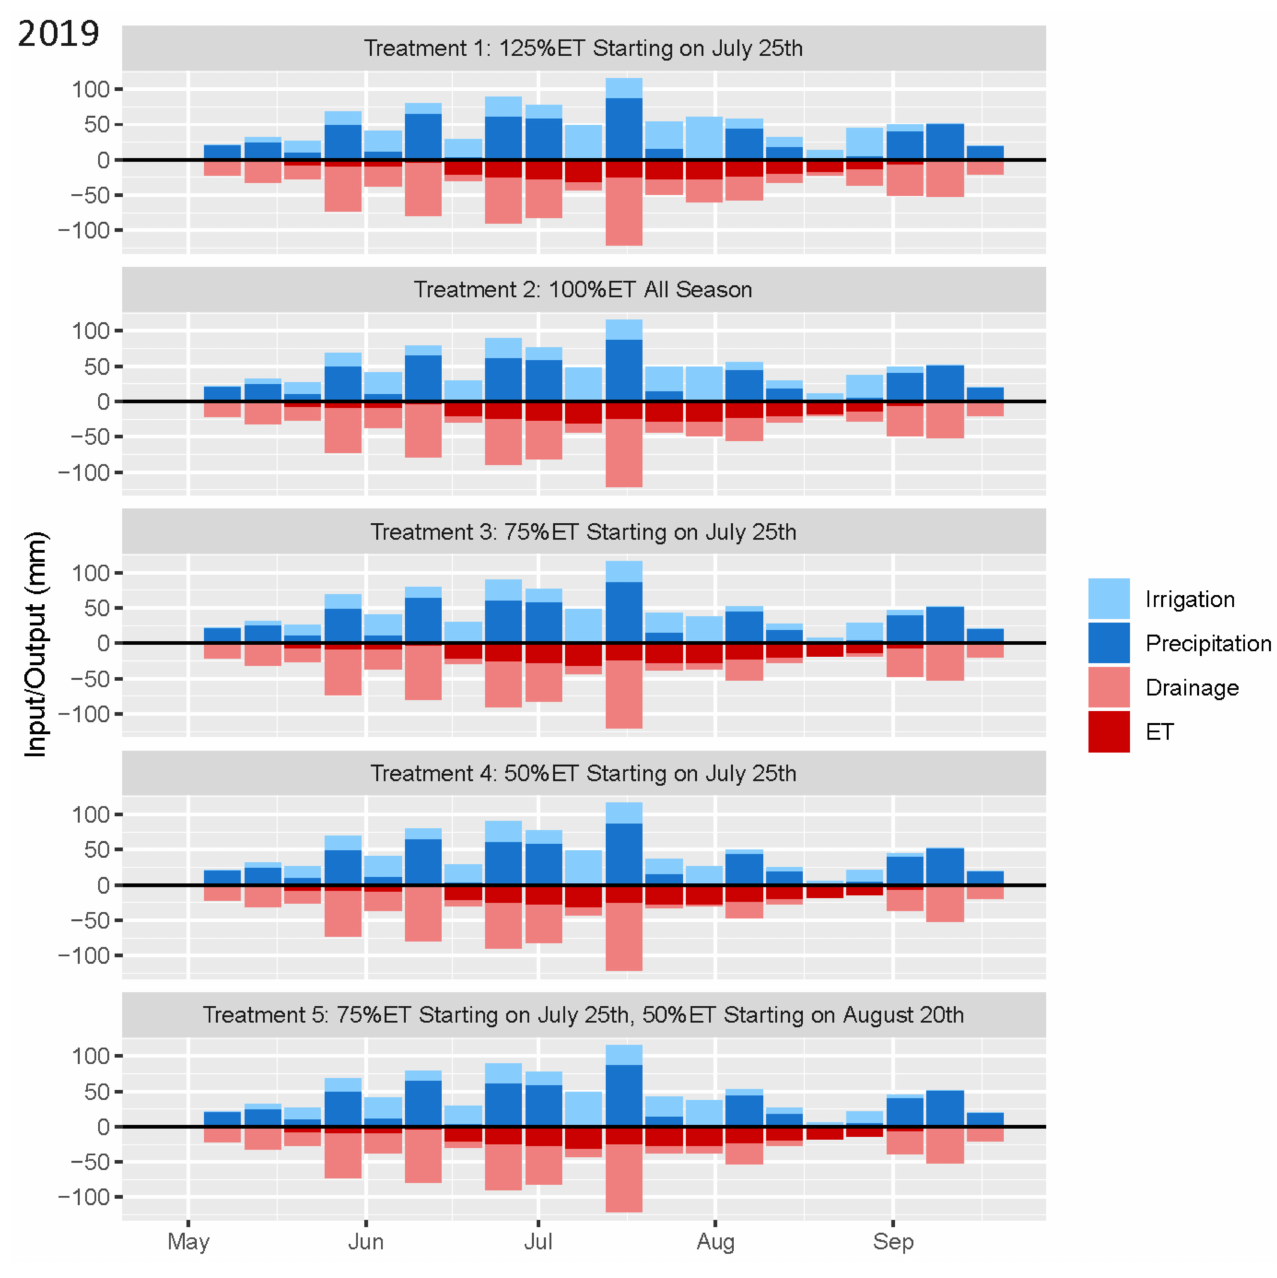
Figure 6. Weekly soil water balance values under each irrigation treatment in